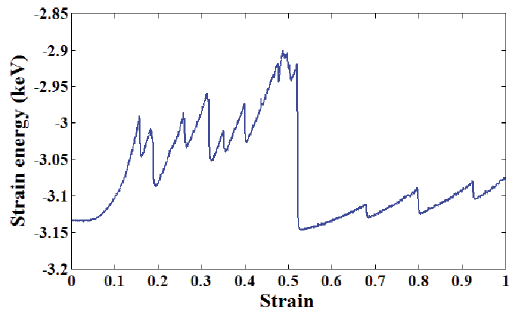
Figure 4: Strain energy of a 30×50 Å 2 zigzag graphenylene versus strain. are considered. As it is seen at a same size, zigzag graphenylenes have larger elastic modulus than armchair ones. However, the difference can be neglected for side lengths larger than 50Å. Besides, increasing